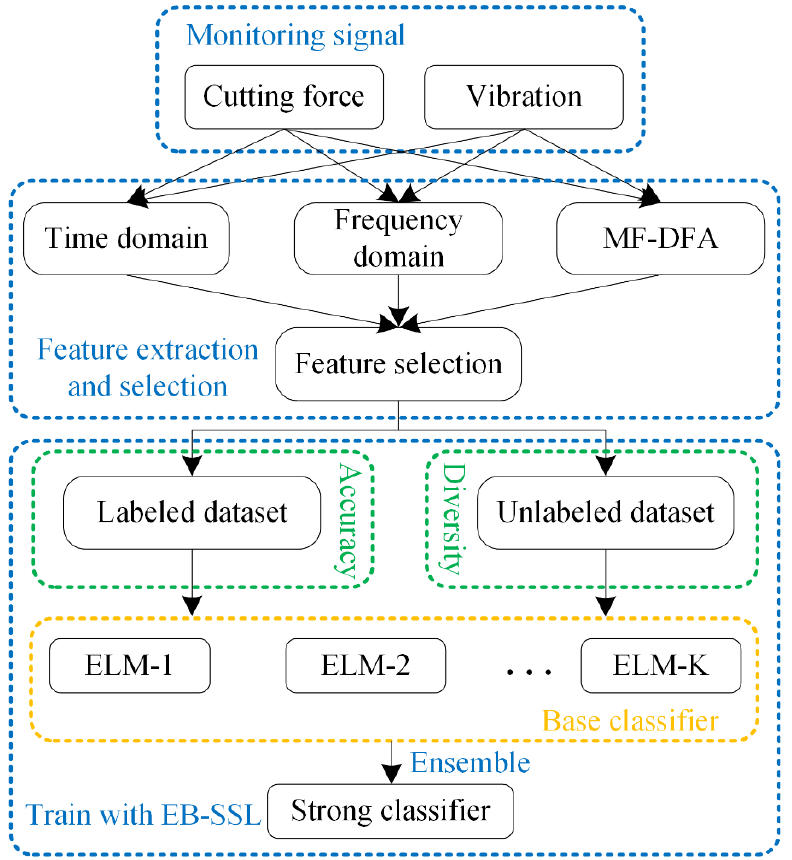
Figure 2. Overall flowchart of the proposed method for chatter detection.